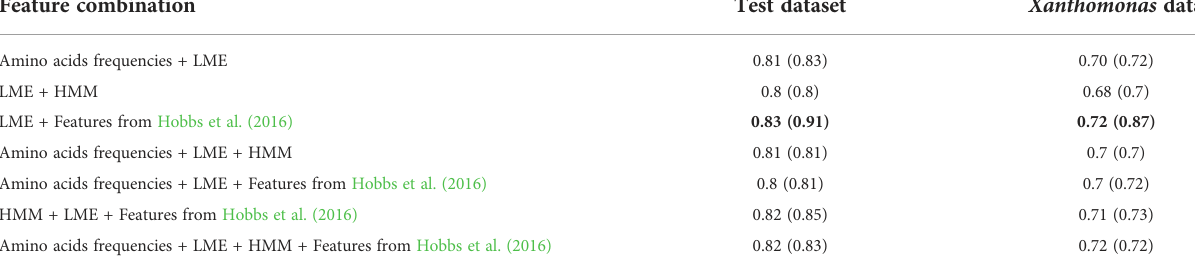
TABLE 3 The performance of combinations of top-scoring features from each group of features.